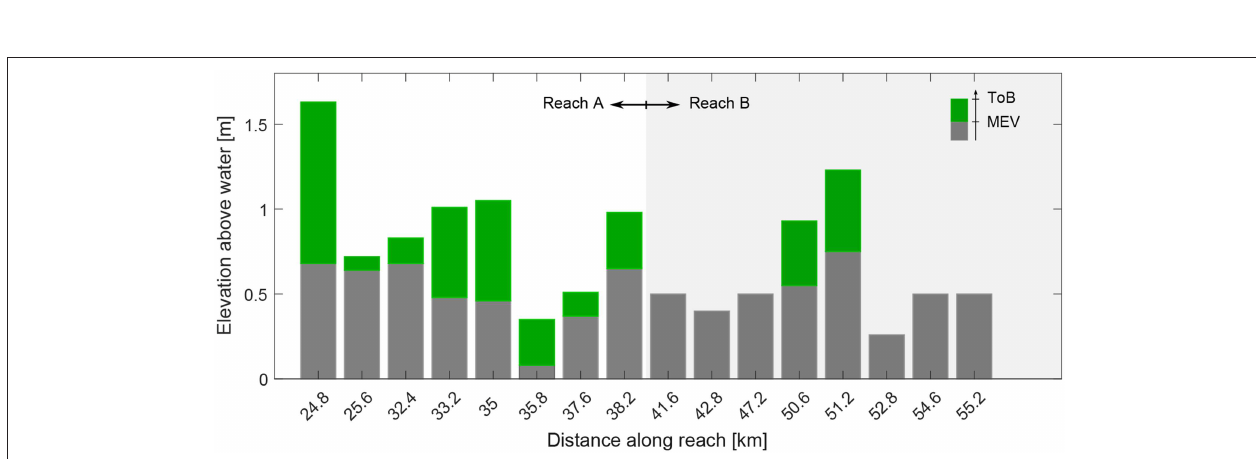
FIGURE 8 | Frequency distribution of the bed elevation for the gravel, pioneer, and dense vegetation classes for vegetated bars in reach A (A) and for bare bars in reach B (B) . A detrended bed elevation of 0 m corresponds to the water surface elevation as in 2014 estimated from the DEM.